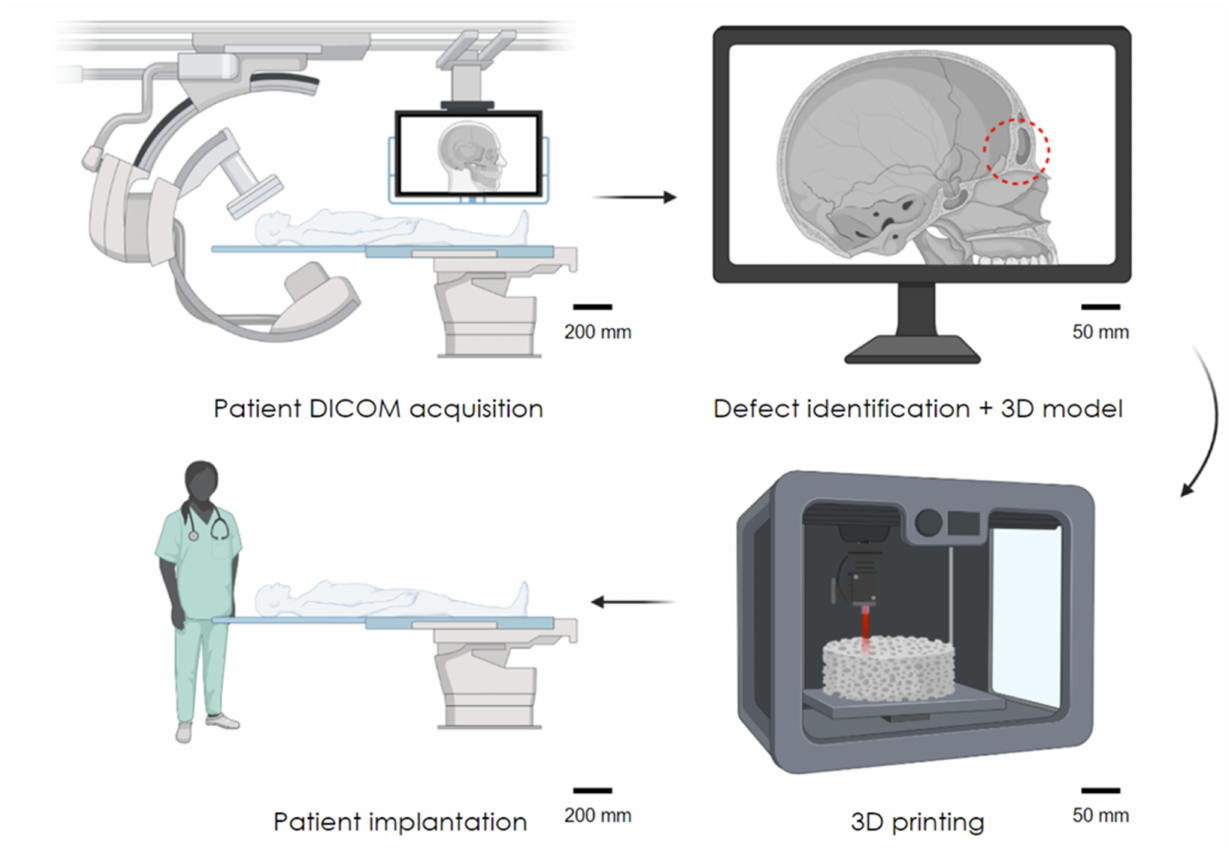
Figure 2. The process of 3D printing implants. Initial patient scans from X-ray, CT, or MRI to the development of a 3D model, following from patient scanning to modelling and implant